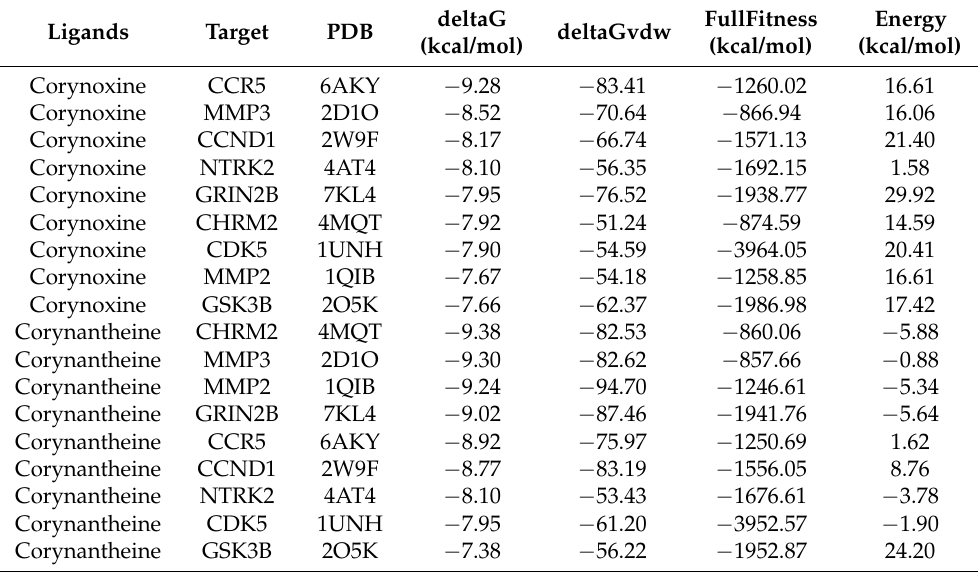
Table 4. Molecular docking of core targets with corynoxine and